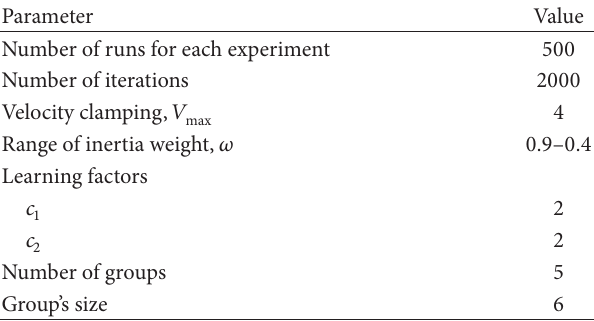
Table 13: Test parameters for experiment on the effect of Δ